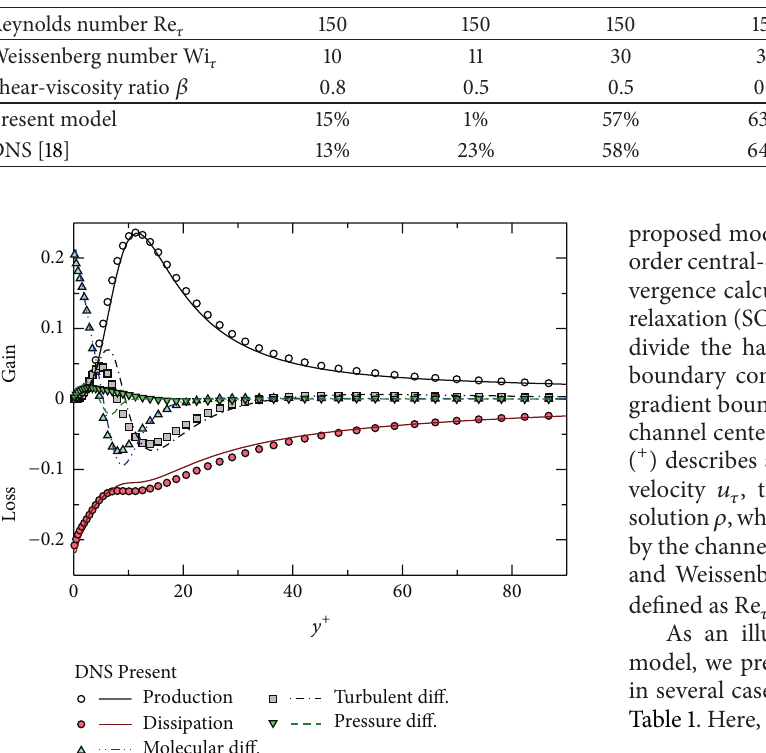
Table 1: Percentage drag reduction DR%.